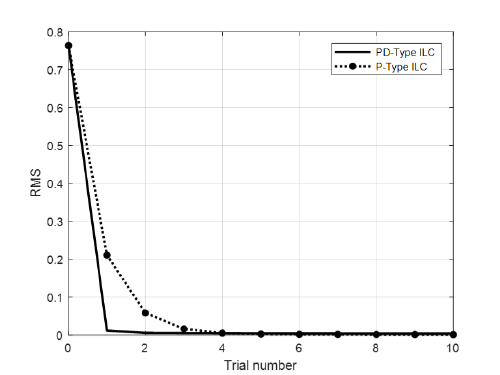
Figure 3. Curve of RMS of norm-bounded uncertain system with the number of